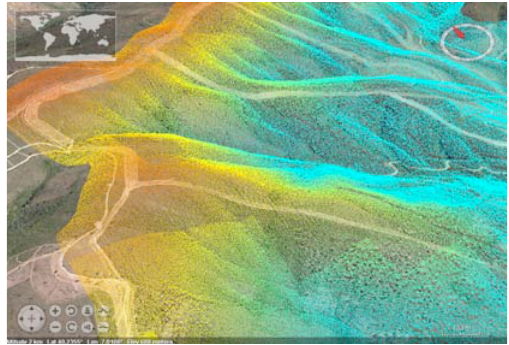
Figure 6 LOD Selection of a few